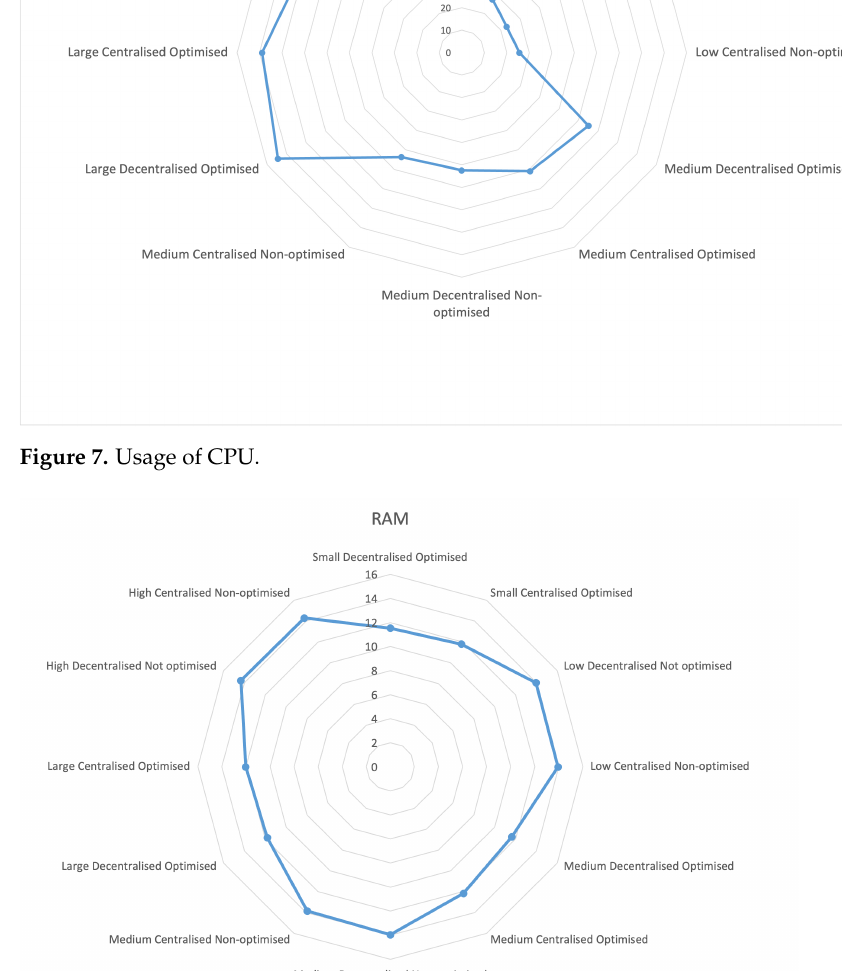
Figure 8. Usage of